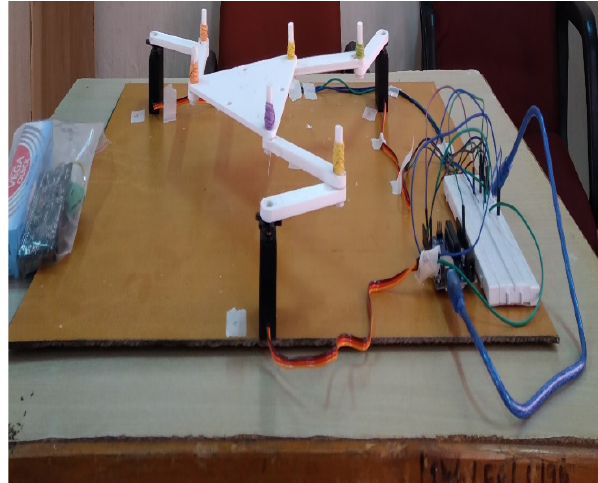
Figure 6. Vector Nodal Solution in